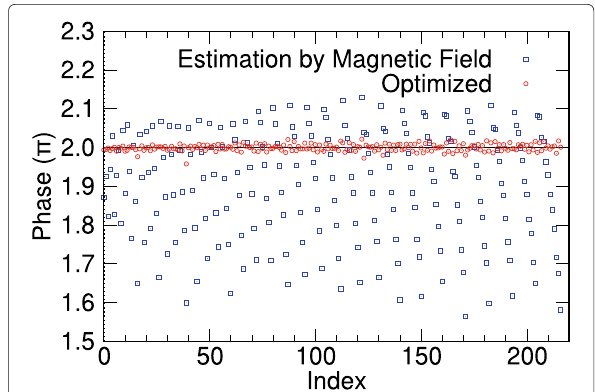
Fig. 11 Accuracy of the optimized p ( g ) . Phase differences of PS1 were calculated by the optimized and estimated p ( g ) using the pairs shown in Table